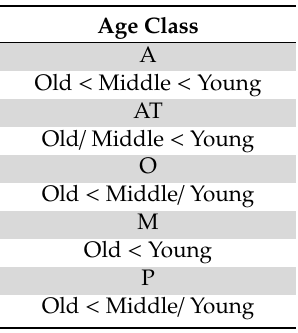
Table 7. Rankings of age class from low to high ratings for every instruction type, resulting from pairwise one-tailed Mann-Whitney U tests.